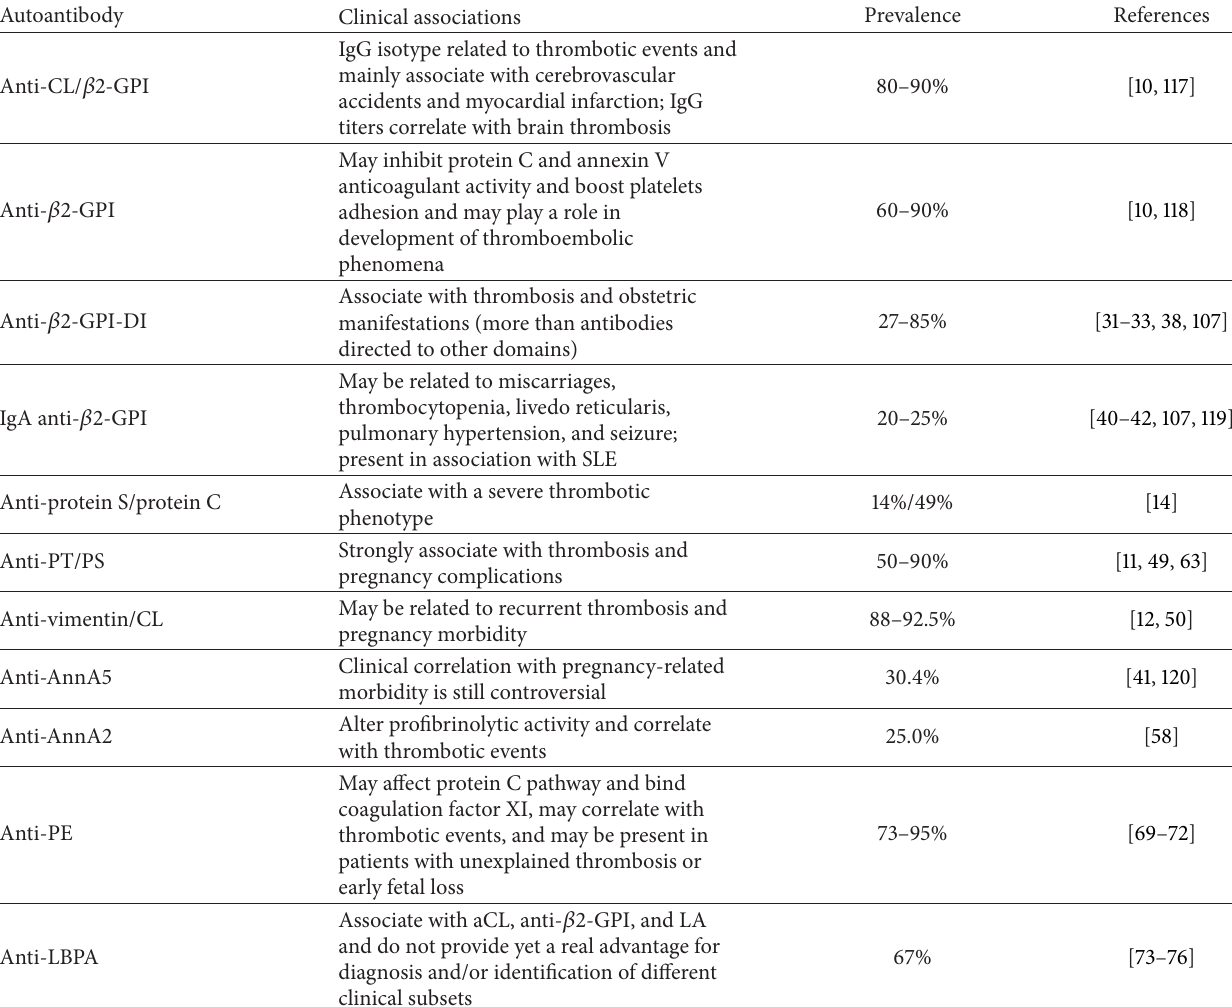
Table 2: Different antibody specificities in